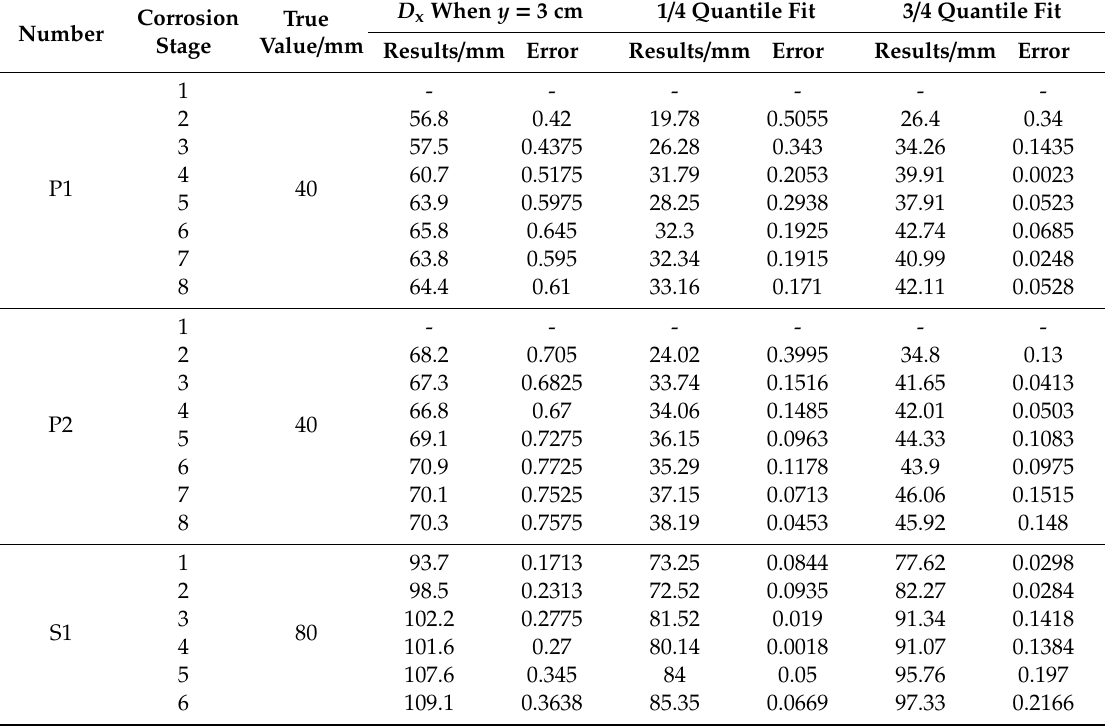
Table A1. The calculation sheet of error.